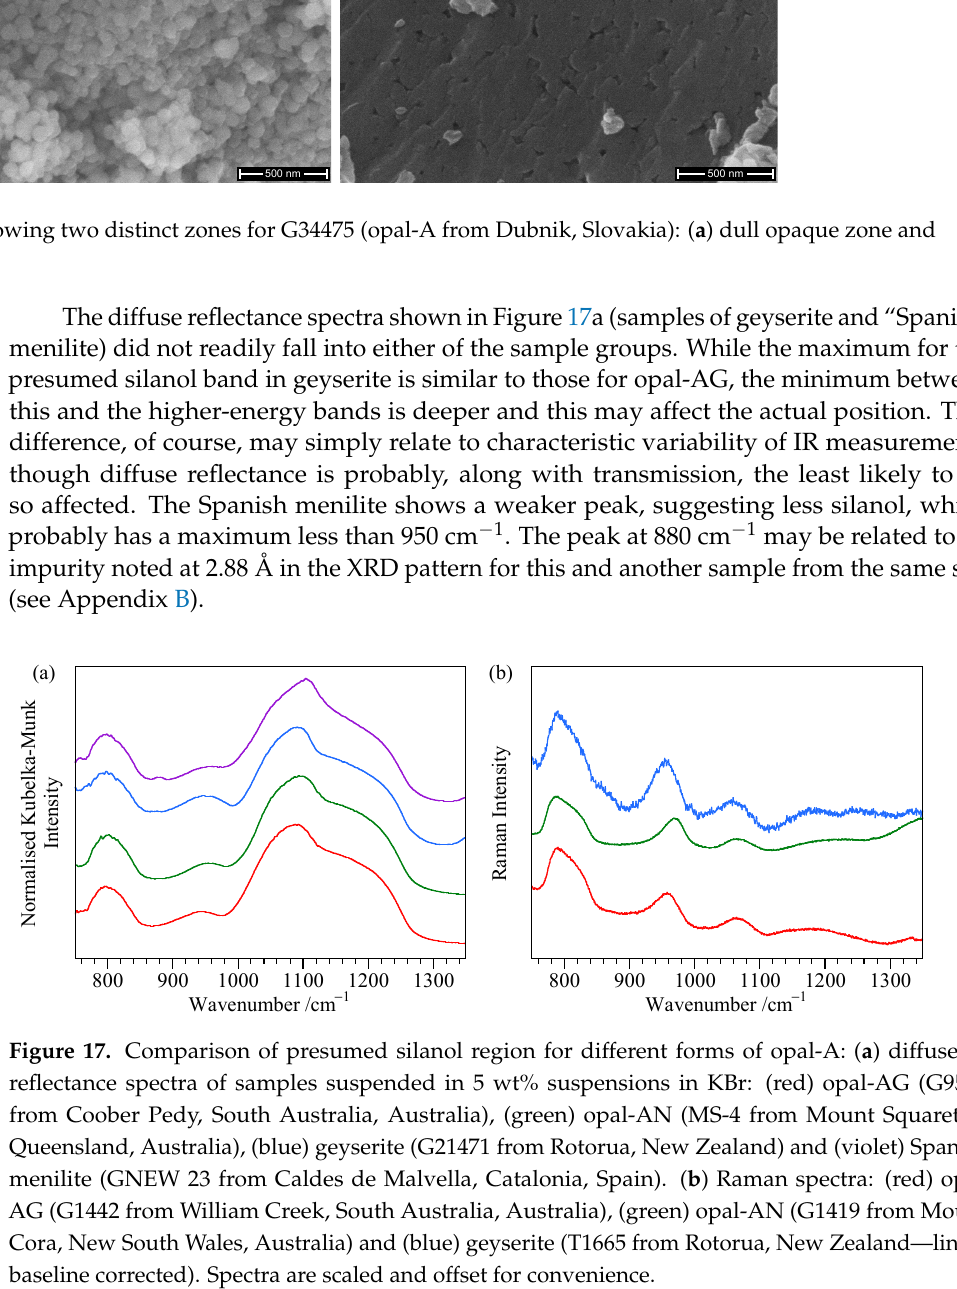
Figure 17. Comparison of presumed silanol region for different forms of opal-A: ( a ) diffuse IR reflectance spectra of samples suspended in 5 wt% suspensions in KBr: (red) opal-AG (G9594 from Coober Pedy, South Australia, Australia), (green) opal-AN (MS-4 from Mount Squaretop, Queensland, Australia), (blue) geyserite (G21471 from Rotorua, New Zealand) and (violet) Spanish menilite (GNEW 23 from Caldes de Malvella, Catalonia, Spain). ( b ) Raman spectra: (red) opal-AG (G1442 from William Creek, South Australia, Australia), (green) opal-AN (G1419 from Mount Cora, New South Wales, Australia) and (blue) geyserite (T1665 from Rotorua, New Zealand—linear baseline corrected). Spectra are scaled and offset for convenience.